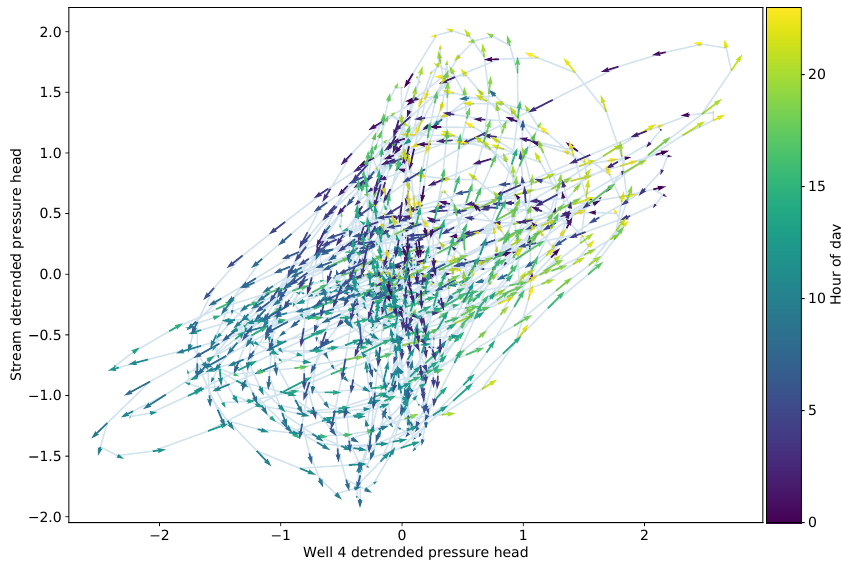
Figure 9. Reconstruction of the phase portrait of the hillslope–stream system from the record of observations. The states are the detrended hydraulic heads at well 4 and at the stream. The lines and the vectors indicate the trajectory and velocity of the states. Colors indicate the time of day at which the system was at that corresponding